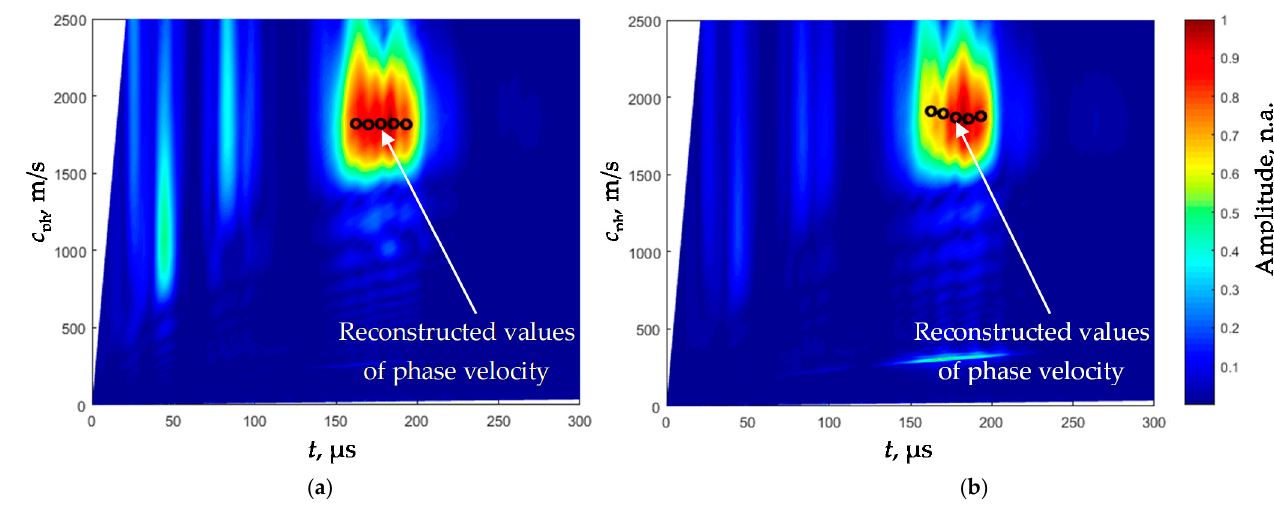
Figure 11. 2D-FFT spectra of the B-scans of the recorded Lamb wave signals (color) and the reconstructed phase velocities of the S 0 mode using the proposed algorithm (dots) of the PVC films with different thickness: ( a ) d 1 = 135 µm, ( b ) d 2 = 180 µm.